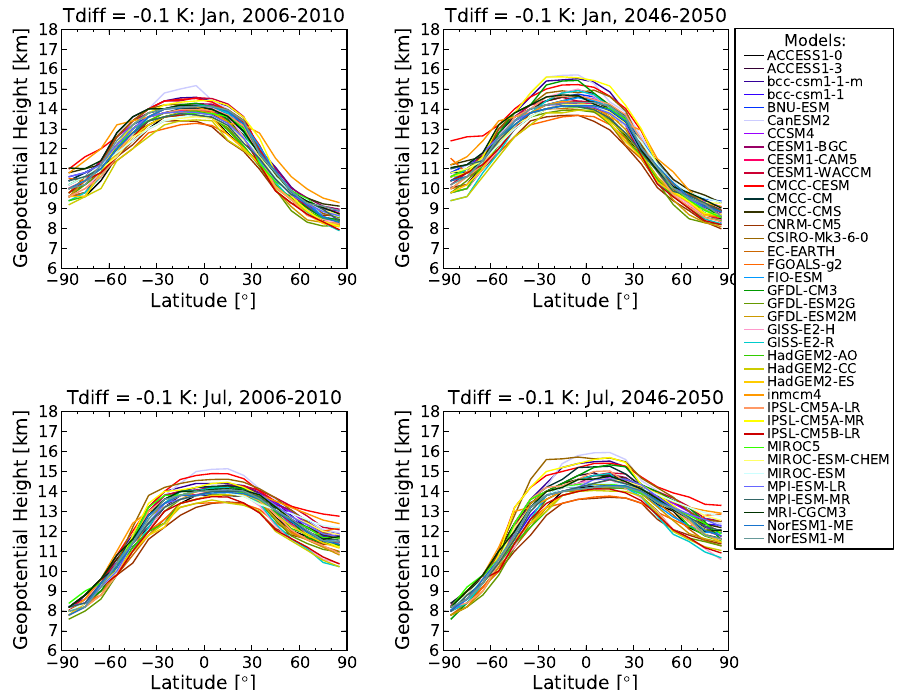
Figure 7. Maximum height of T diff = − 0 . 1 K for all models, from 2006 to 2010 (left column) and 2046 to 2050 (right column), for January (top row) and July (bottom row).